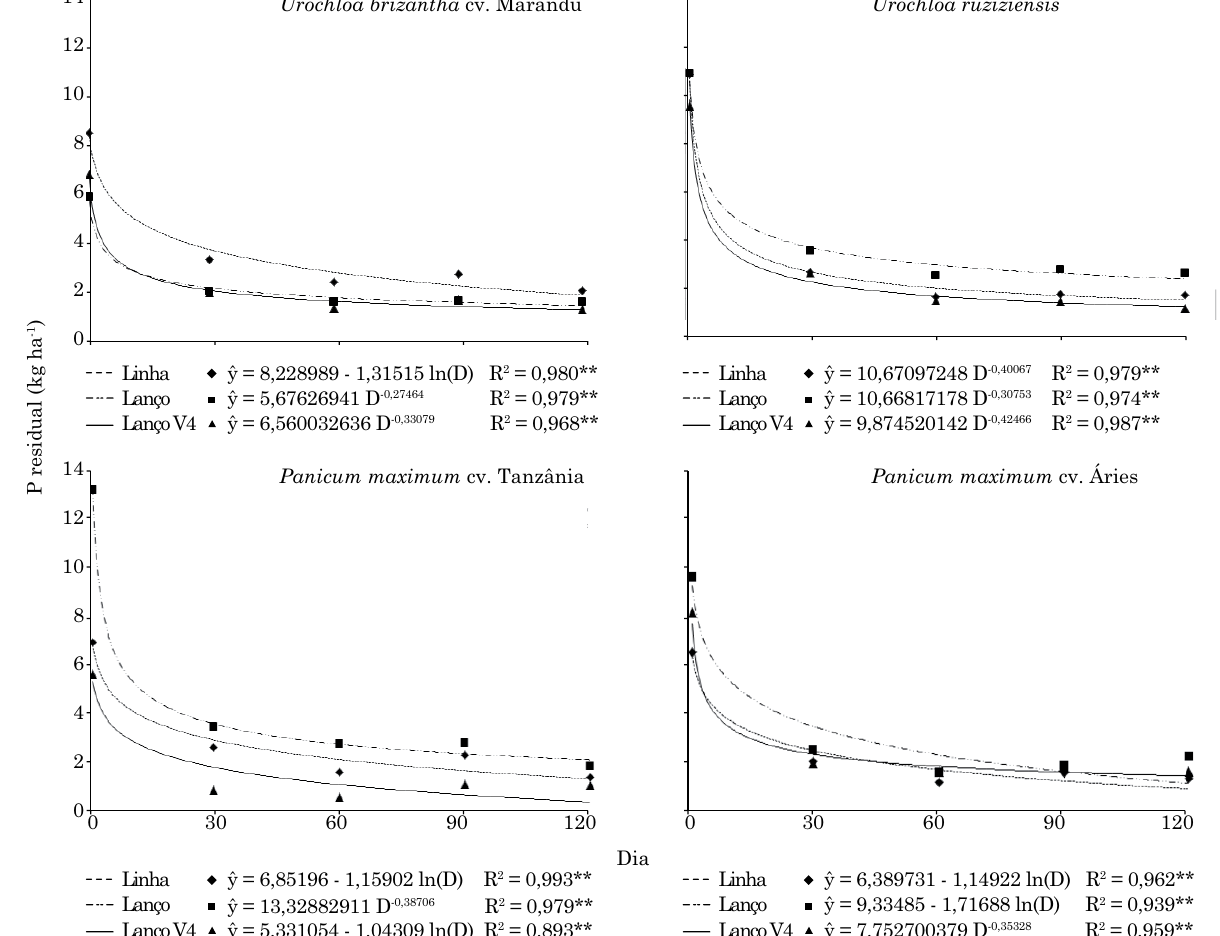
Figura 3. Fósforo residual na palhada das forrageiras remanescente no solo até 120 dias durante o cultivo da soja, para as condições das forrageiras semeadas no plantio do milho, na linha (Linha) ou a lanço (Lanço) ou no estádio V4 a lanço (LançoV4). ** e * p<0,01 e <0,05,